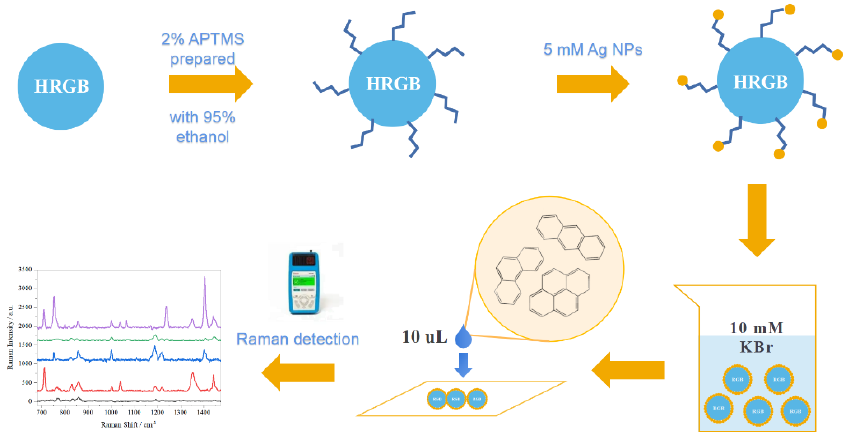
Scheme 1. Schematic representation of the preparation and application of HRGB – SERS